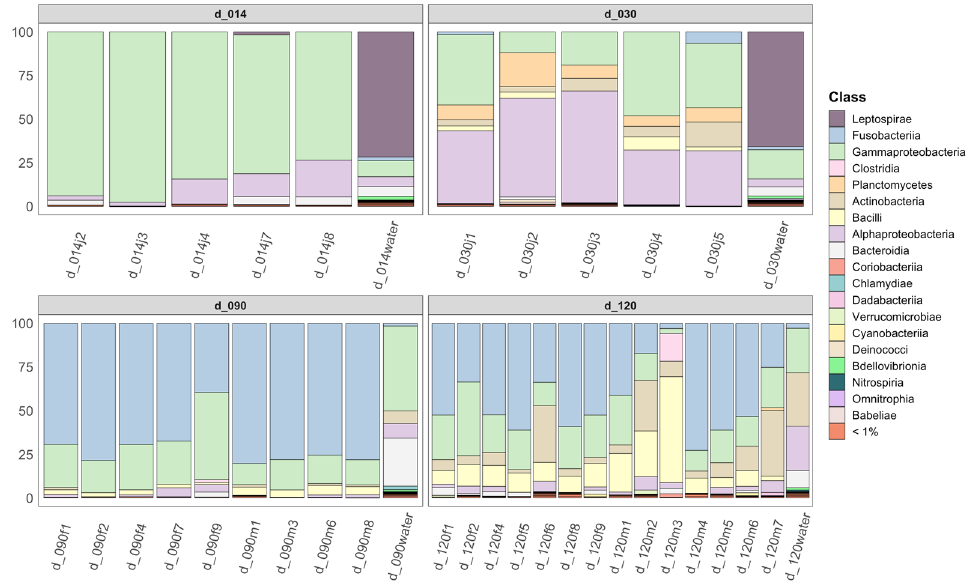
Figure 3. Relative abundance of the bacterial taxa at the class level across individual fish and water samples from the different dates. All taxa with abundance <1% in the whole dataset are grouped. Nomenclature according to Table S1.